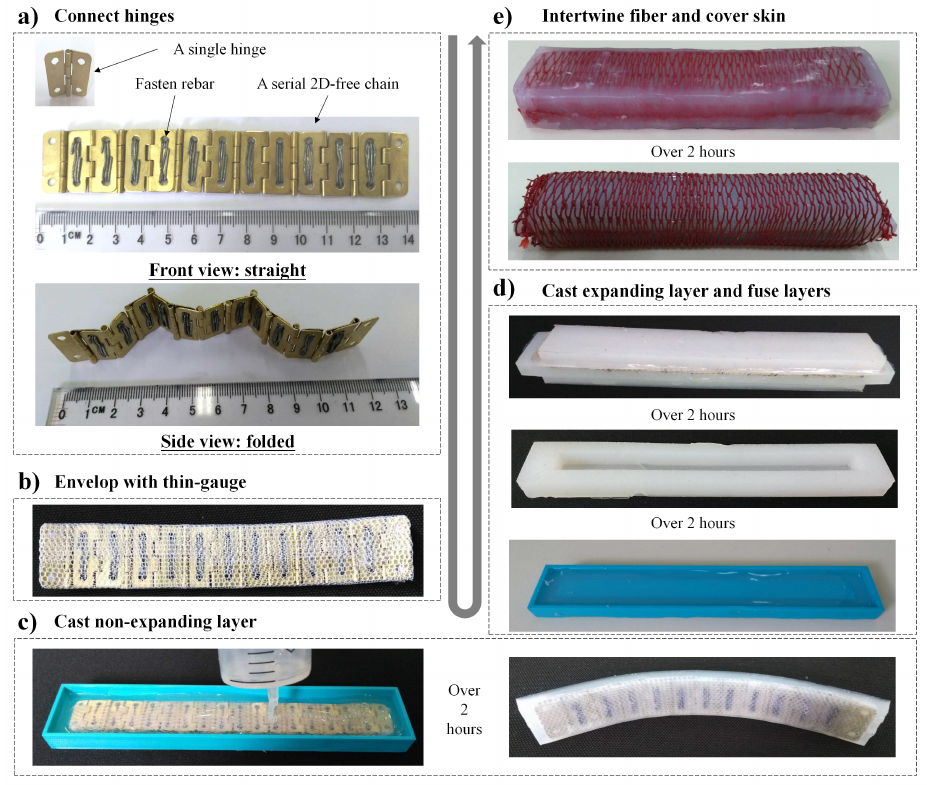
Figure 4. Fabrication process of